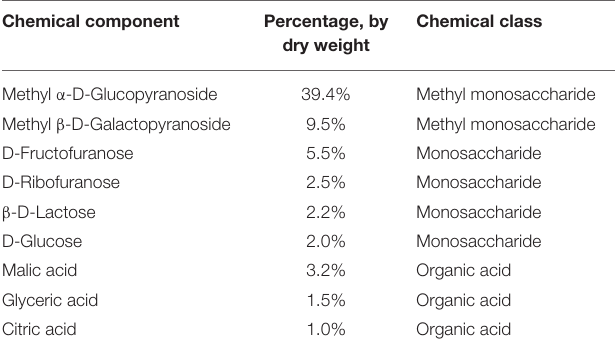
TABLE 2 | Chemical composition of SHC of molecules with a content of > 1%. Chemical